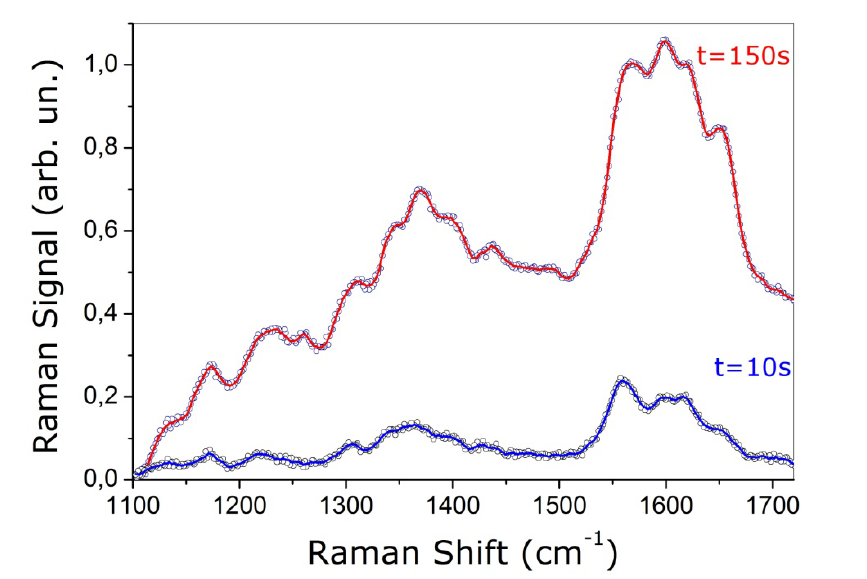
Figure 4. Resonant Raman spectrum of an optically trapped healthy RBC acquired with an integration time of 10 and 150 s.